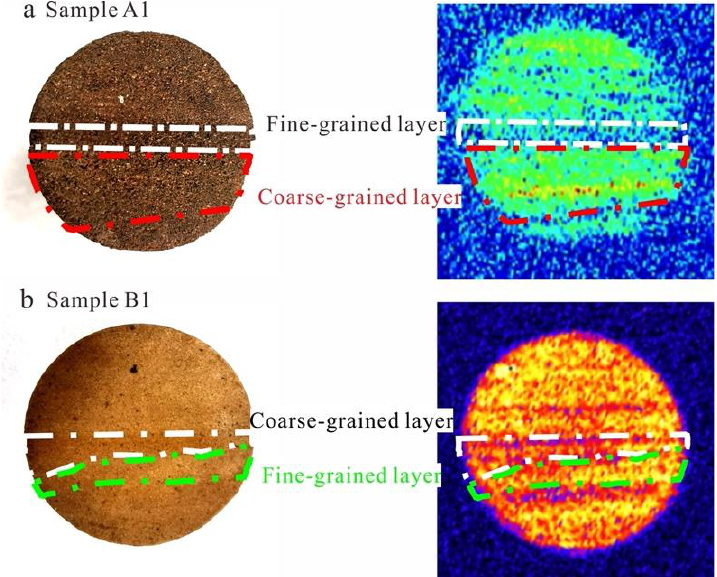
Figure 9. Photographs ( left ) and MRI images ( right ) of ( a ) Sample A1 and ( b ) Sample B1.